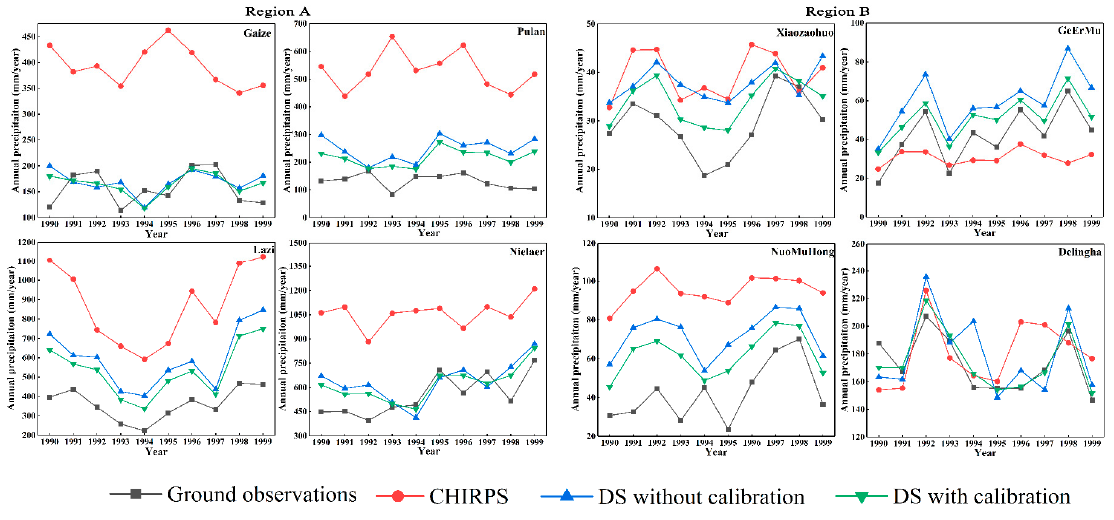
Figure 10. Mean annual precipitation volumes based on ground observations, and precipitation estimates obtained from CHIRPS and DS, from 1990 to 1999, at specific stations in both regions A and B.